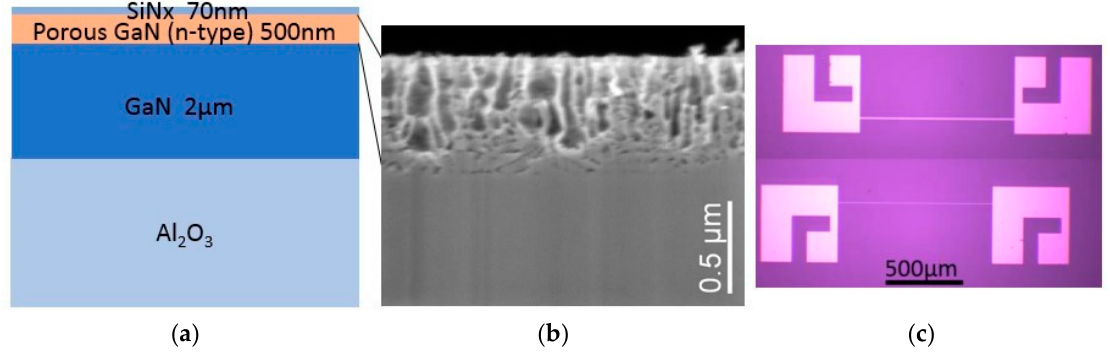
Figure 1. Experimental sample: ( a ) sample structure; ( b ) SEM image of the porous GaN layer; ( c ) optical photograph of the 3 ω test structures and their Kelvin-connection